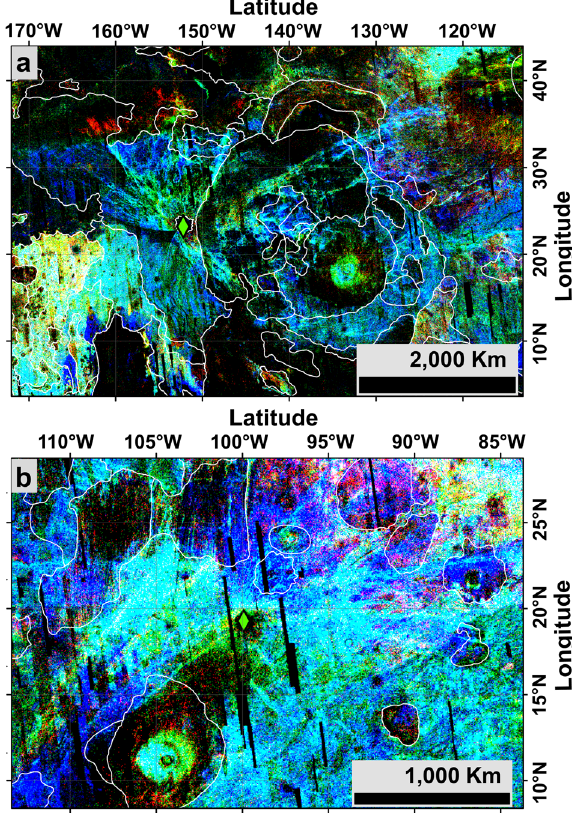
Fig. 2 Close-up of cratering density around the two most likely crater source of the depleted shergottites. a Tooting and ( b ) 09-00015 craters (respectively label 3 and 5 on Fig. 1a). The location of the two craters are shown as green diamond. White outlines are contacts between geological units 44 . The readers are referred to Fig. 1b for the legend of the cratering density.